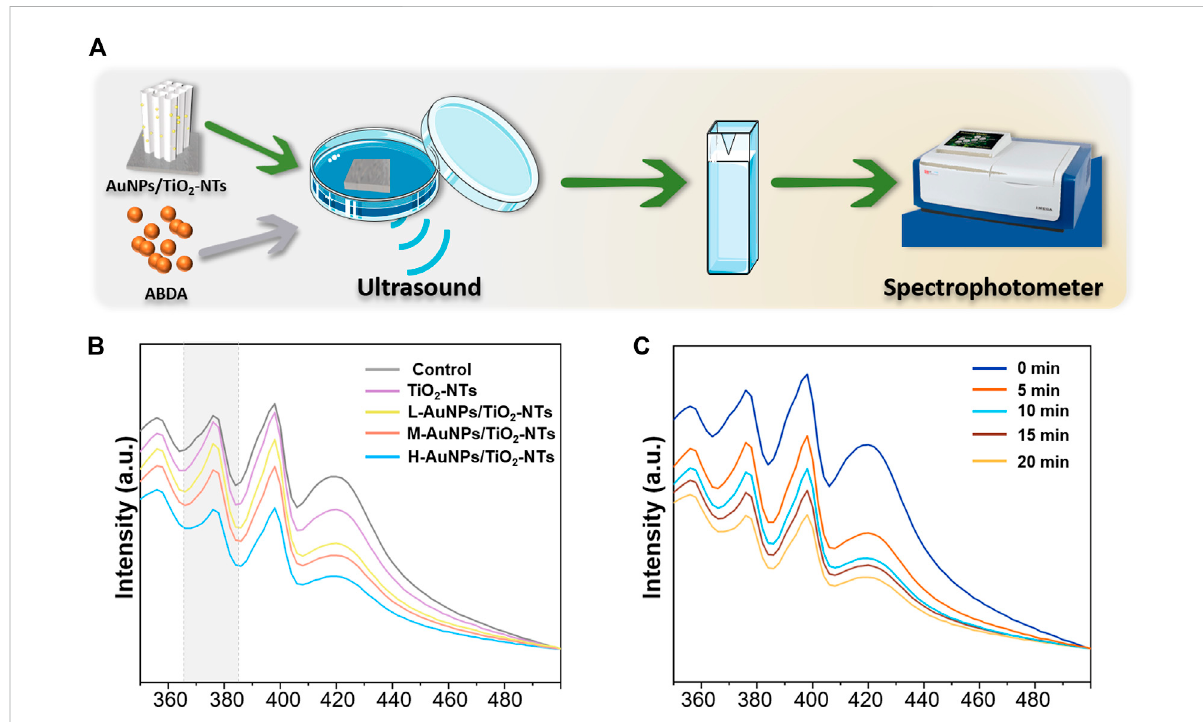
FIGURE 3 (B) ROS generation testi fi ed by the absorbance of ABDA under ultrasound irradiation for (A) Schematic images of 1 O 2 generation with time. 10 min. (C) The amount of ROS generation changed in the H-AuNPs-TNTs group under ultrasound treatment in 20